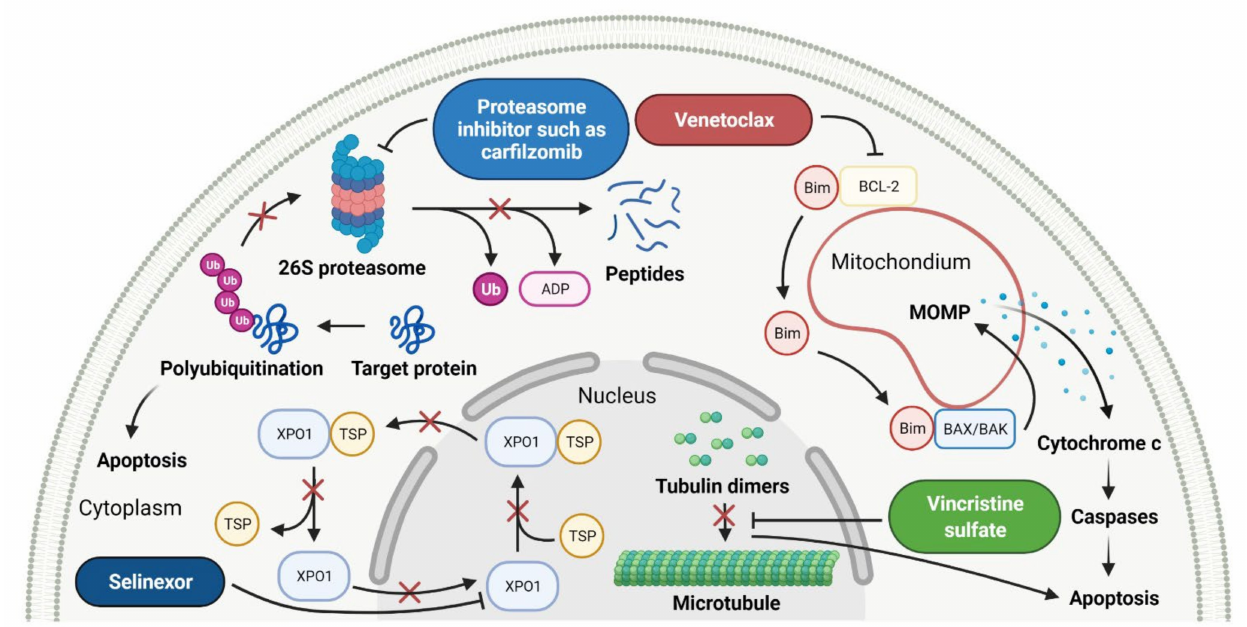
Figure 6. The four types of protein inhibitors in the treatment of hematological malignancies and their mechanisms of action. BCL-2 : B-cell leukemia/lymphoma-2. Bim : BCL-2-like protein 11. BAX : BCL-2-associated X protein. BAK : BCL-2 antagonist/killer 1. MOMP : mitochondrial outer membrane permeabilization. XPO1 : exportin-1. TSP : tumor suppressor protein. Ub : ubiquitin. ADP : adenosine diphosphate. Created with